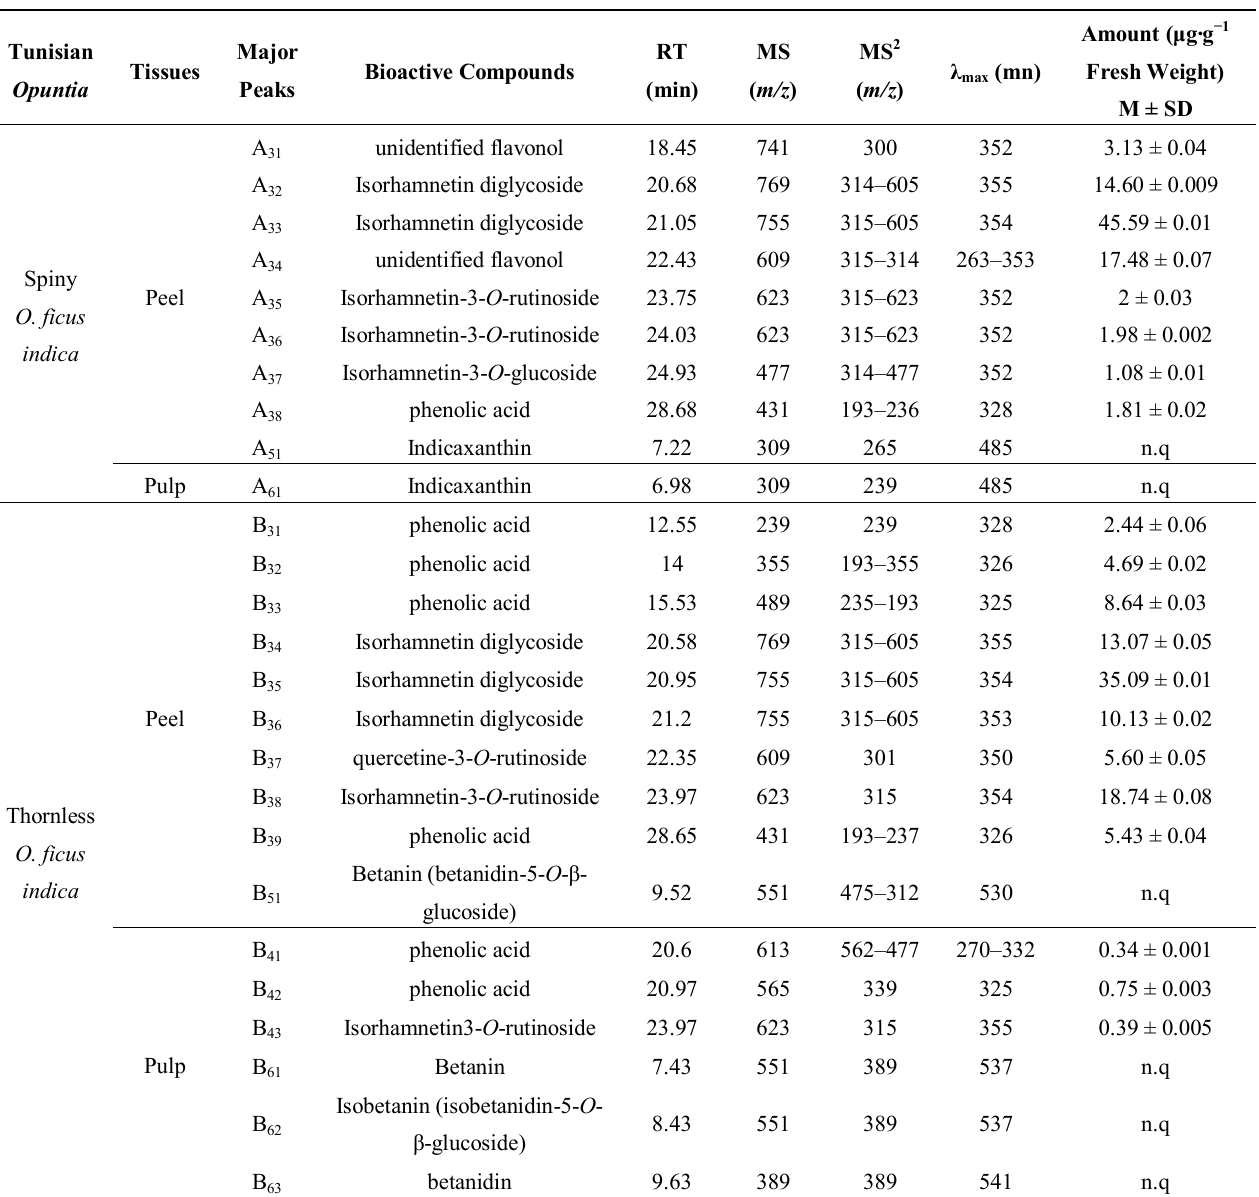
Table 2. RT, Spectral, Characteristic ions (MS and MS 2 ) and main amount compounds data from pulp and peel methanol extract of Tunisian O. ficus indica and O. stricta